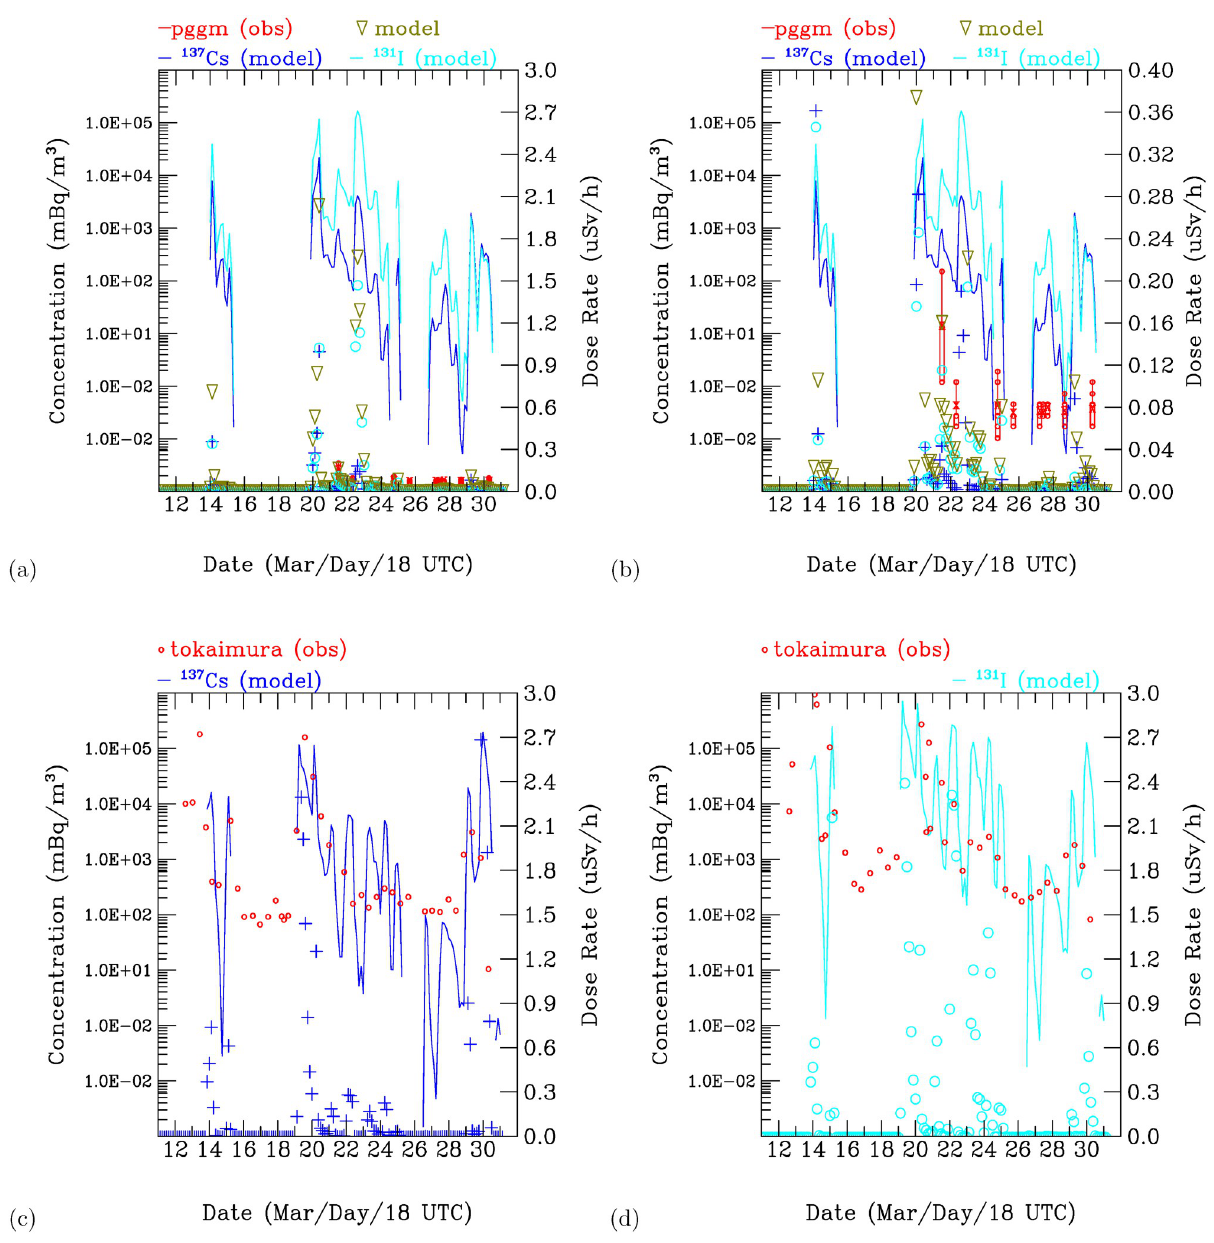
Fig 13. Time-series variations in calculated radionuclides 137 Cs and 131 I over the Port of Tokyo area and comparisons with the PGGM observations. The concentrations of 137 Cs (blue) and 131 I (sky blue) are in units of Bq/ m 3 (left y-axis), the blue circles are 137 Cs , the blue crosses are 131 I , and the dark green triangles are 137 Cs + 131 I in the converted units of μ Sv/h. The red circles are the PGGM observations. The air dose rates range between (a) 0.0 and 3.0 and (b) 0.0 and 0.4 μ Sv/h. (c) and (d) show comparisons of 137 Cs and 131 I at the Tokaimura (36.4356˚ N , 140.6025˚ E )